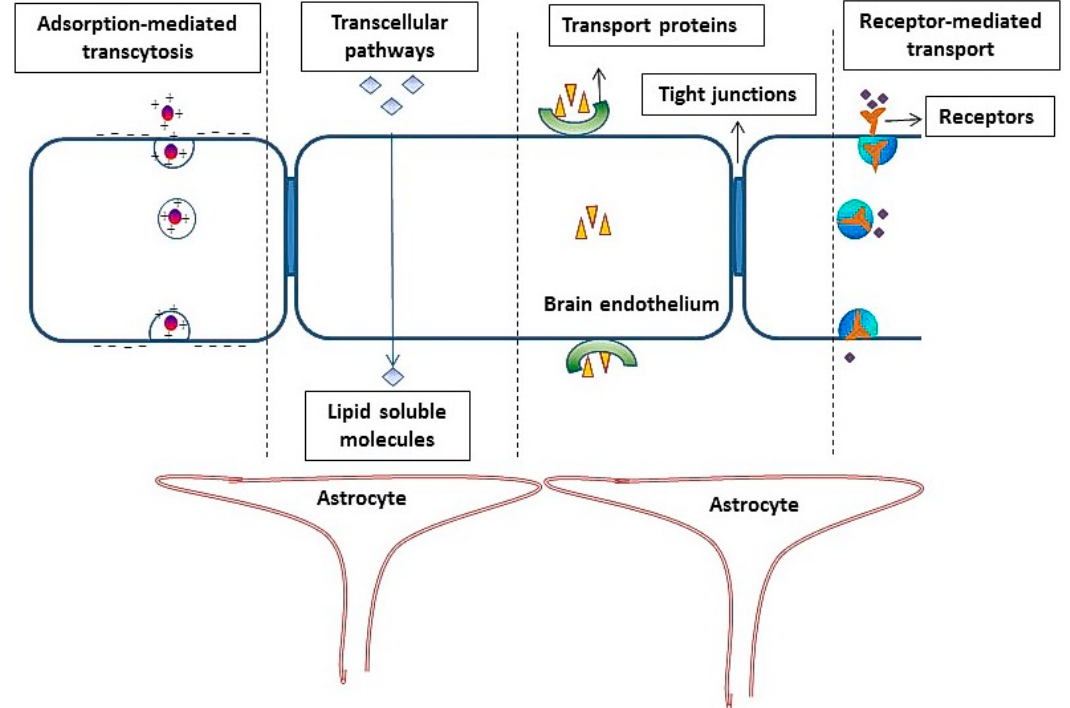
Figure 1. Schematic representation of the blood brain barrier and various transport processes across the brain endothelial layer.